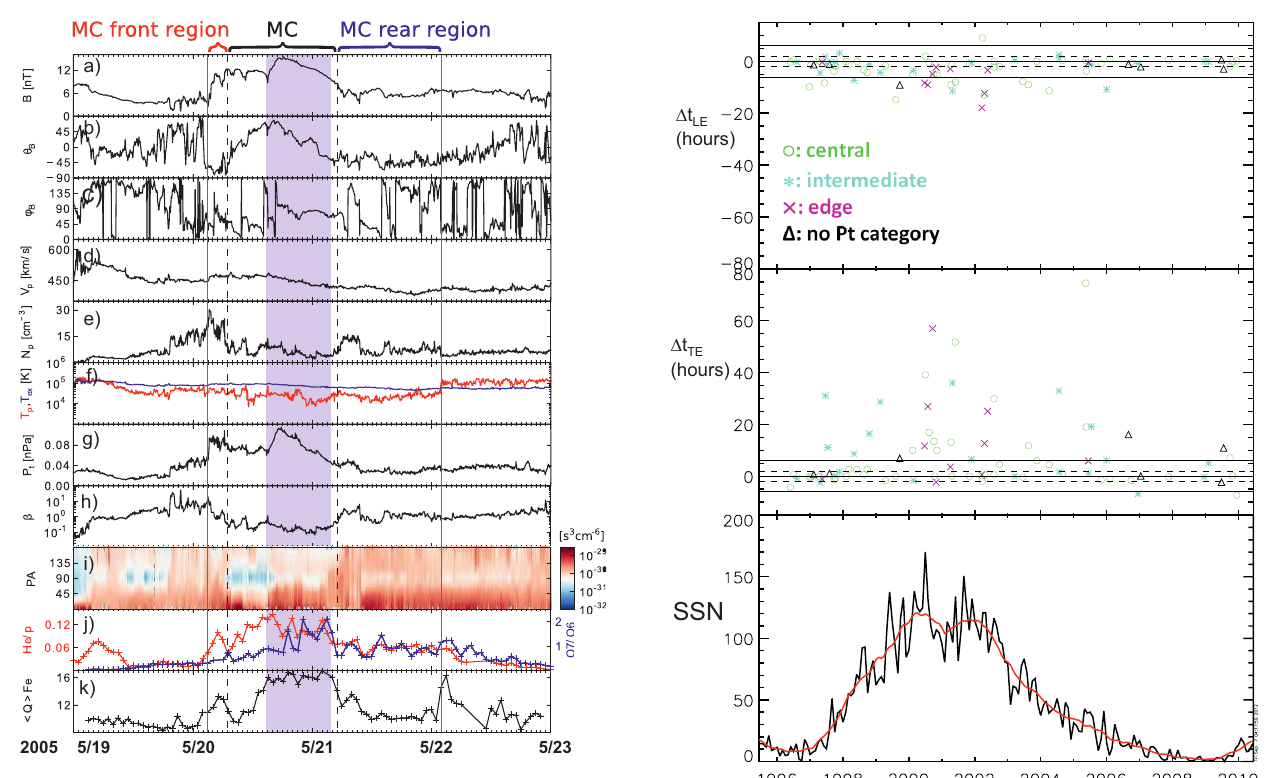
Fig. 2. ACE observations of an event observed on 20–21 May 2005. The panels show from top to bottom: (a) – (c) magnetic field mag- nitude, latitude and longitude angles in GSE, respectively, (d) solar wind speed, (e) density, (f) measured proton temperature (red line) and expected proton temperature (blue line), (g) perpendicular to- tal pressure, (h) plasma beta, (i) suprathermal electron pitch angle spectrogram at 272eV, (j) helium to proton ratio (red), O + 7 / O + 6 ratio (purple), and (k) mean iron charge state. The red solid lines bound the ICME interval (from the RC list) and the pair of black dashed lines the MC interval (from the Wind list). The highlighted region marks the interval of the unperturbed flux rope from the Grad–Shafranov reconstruction; for details of which see Sect. 4.